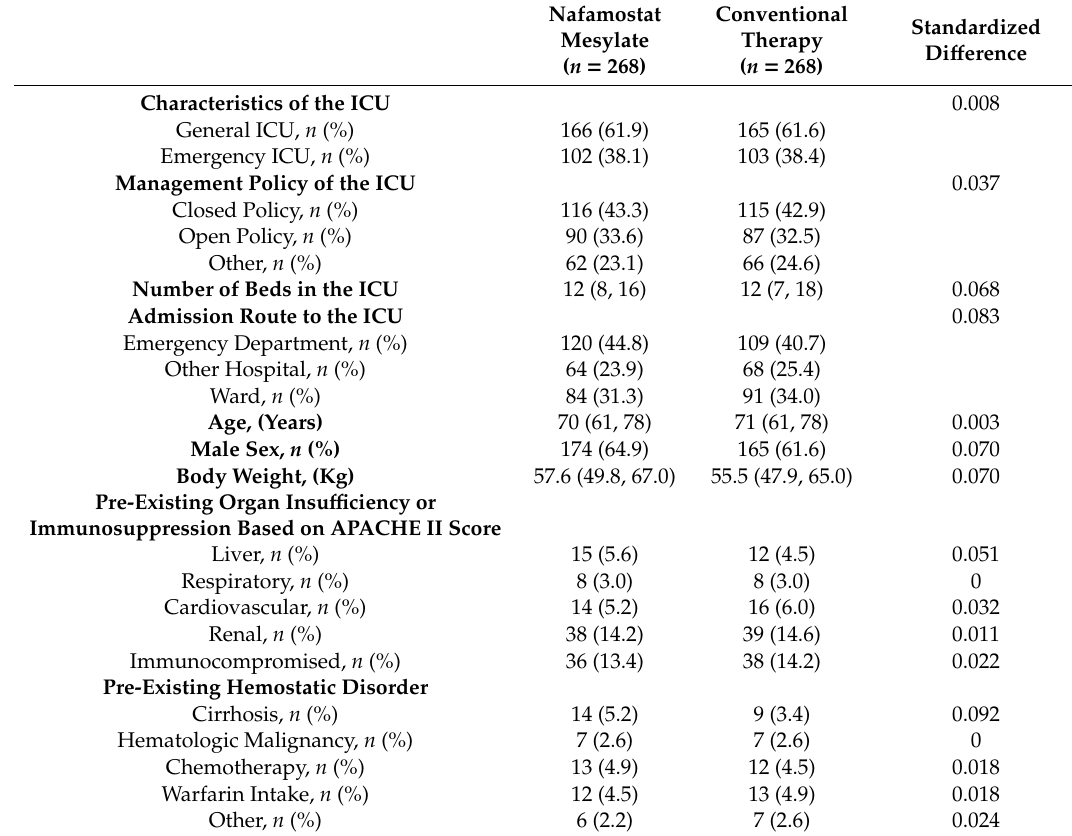
Table 2. Patient characteristics and treatments in the nafamostat mesylate and conventional therapy groups after propensity score